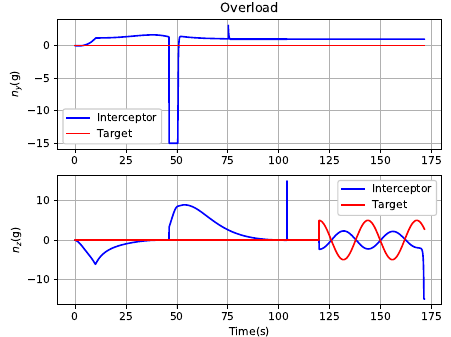
Figure 10. Overload of interceptor (target